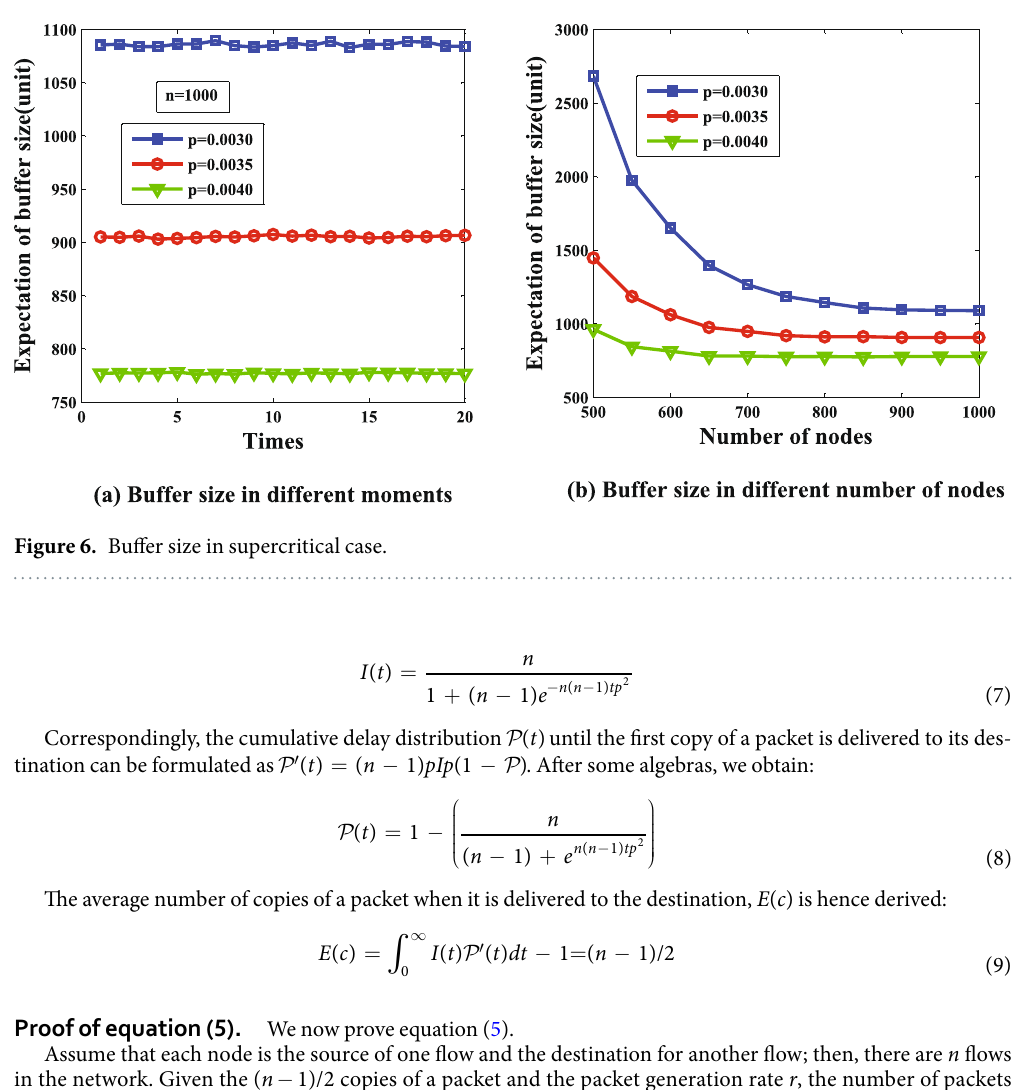
Figure 5. Number of nodes in the largest connected cluster and SET.